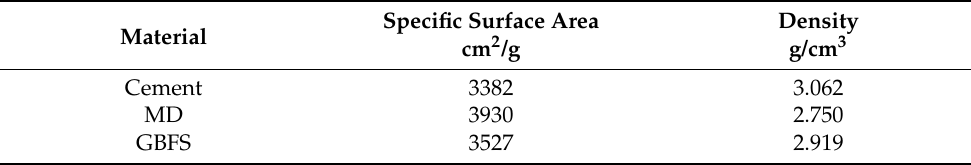
Figure 4. XRD analyses of the materials: ( a ) CEM I 42.5 R, ( b ) MD, ( c ) GBFS. Table 3. Physical properties of the raw materials.